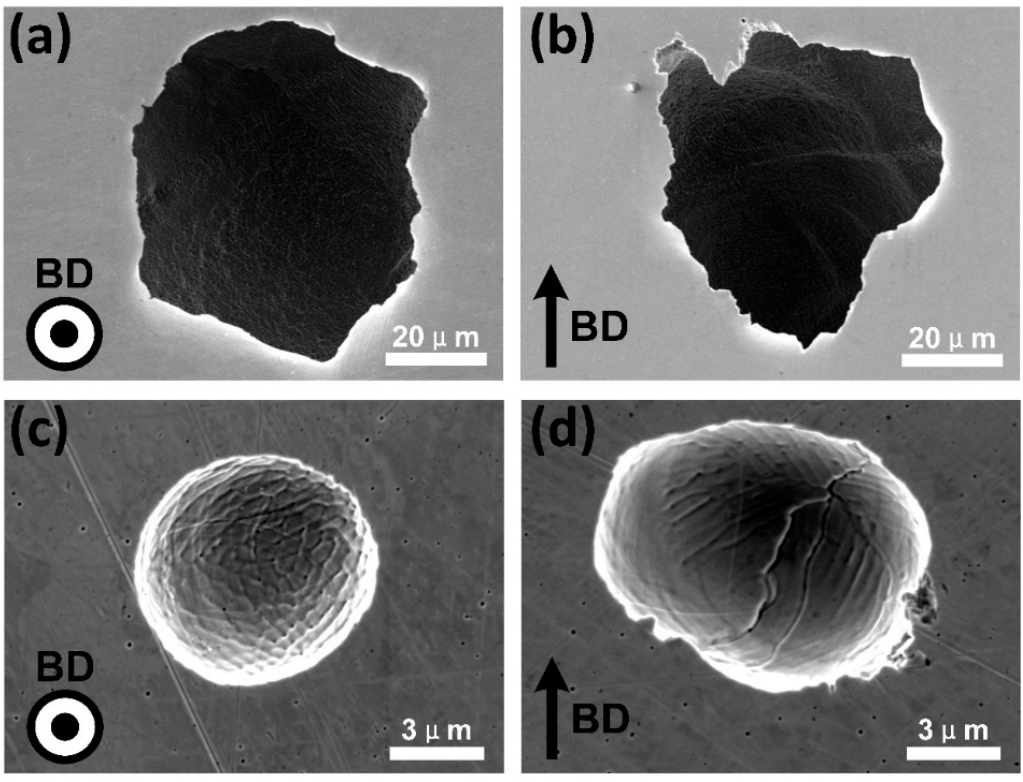
Figure 12. SEM images of the corroded surface for the ( a , c ) XOY plane and ( b , d ) XOZ plane after polarization test in 3.5 wt % NaCl solution. ( a , b ) Were pits with higher corrosion degree, ( c , d ) were pits with lower corrosion degree.